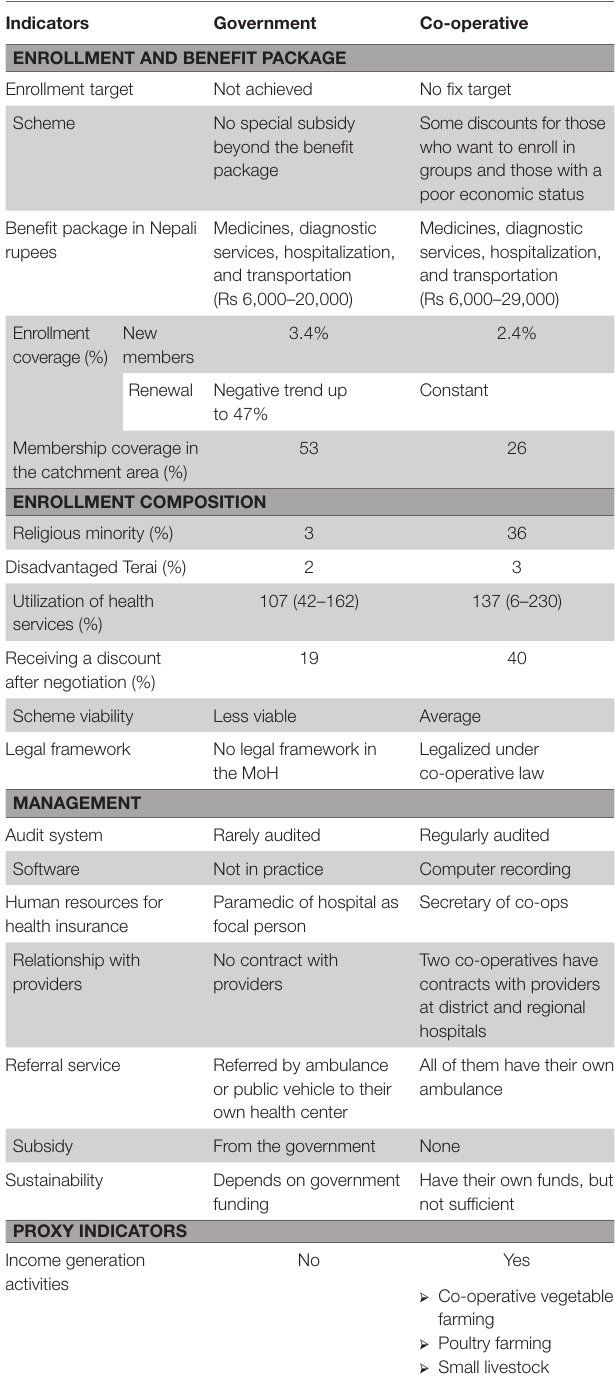
community-based health insurance